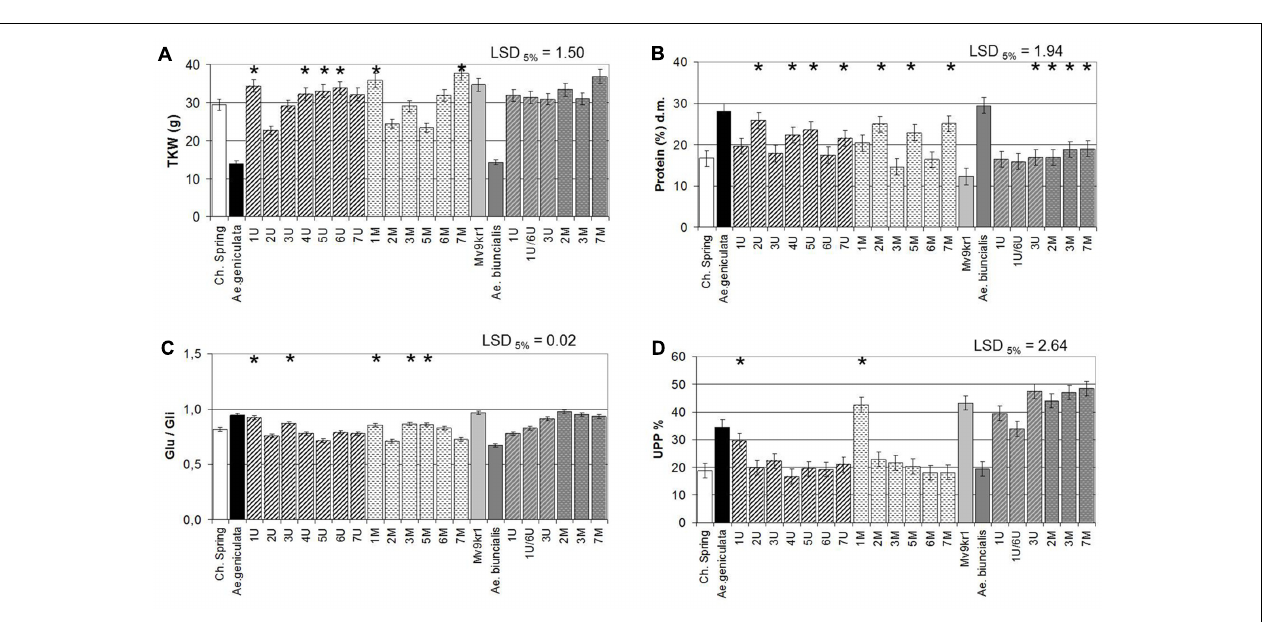
FIGURE 2 | Compositional properties of mature grains of two lines of bread wheat (cv. Chinese Spring and Mv9kr1 line), two Aegilops species ( Ae. geniculata and Ae. biuncialis ), and wheat– Aegilops chromosome addition lines. (A) TKW, (B) protein, (C) Glu/Gli, (D) UPP%. Gli, gliadin; Glu, glutenin; LSD, least significant difference; TKW, thousand kernel weight; UPP, unextractable polymeric protein. ∗ Significantly higher than the wheat ( Triticum aestivum )